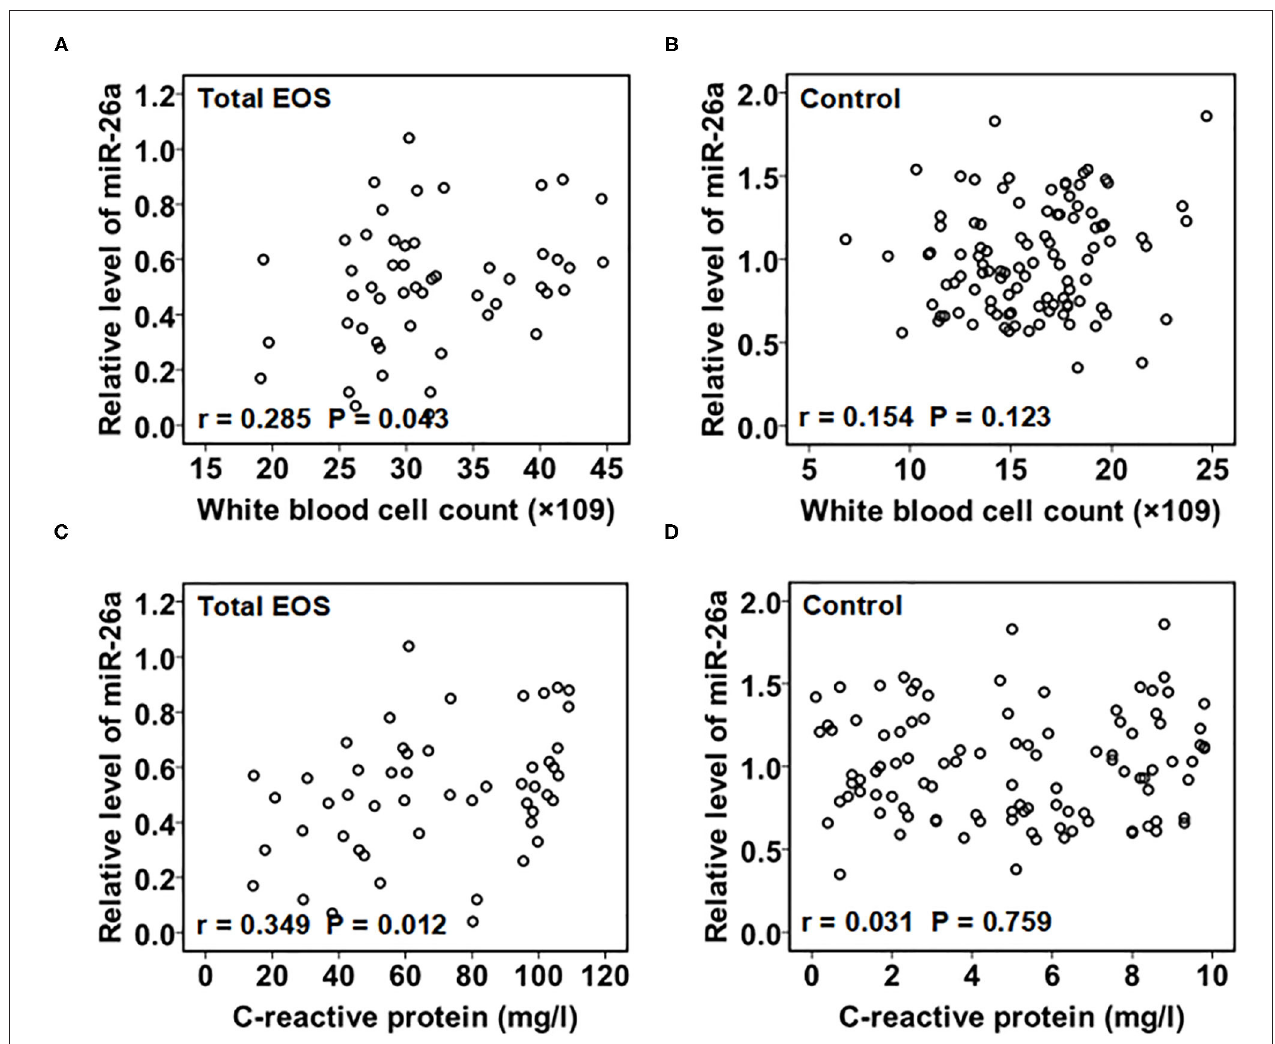
FIGURE 2 | Association of baseline miR-26a in peripheral blood mononuclear cells with baseline C-reactive protein and white blood cell count. In (A,B) , baseline association between miR-26a and white blood cell count was assessed separately in the total EOS and control groups. In (C,D) , baseline association between miR-26a and C-reactive protein was assessed separately in the total EOS and control groups. In the process, Pearson correlation analysis was adopted, and “ P < 0.05” indicates a statistically significant difference. Total EOS, Newborns with clinical features of sepsis.